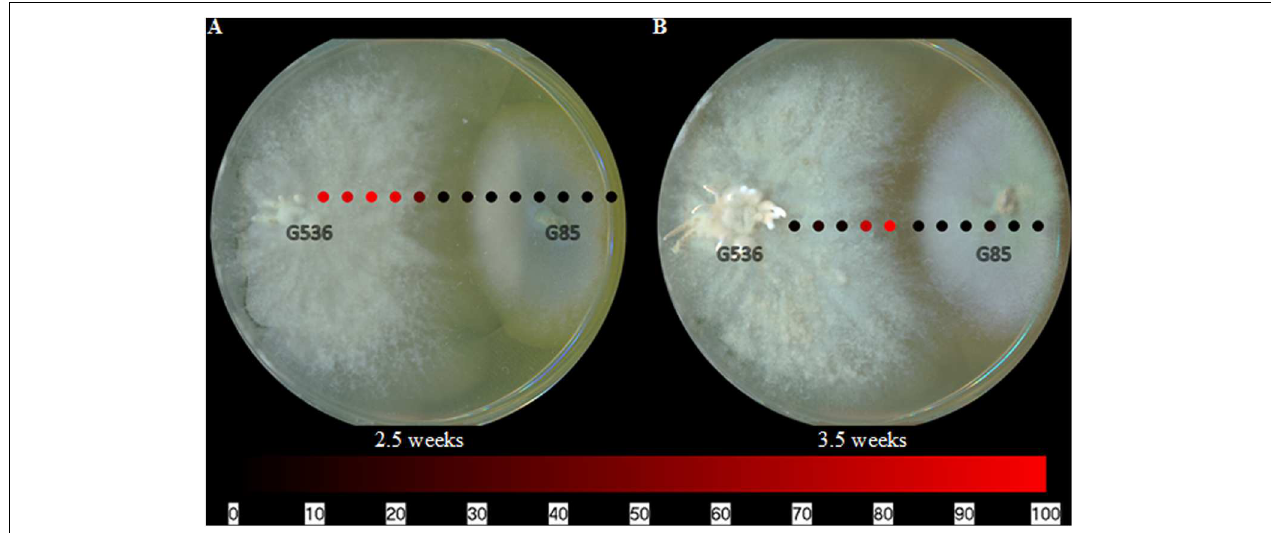
FIGURE 5 | The spatial distribution of griseofulvin from X. cubensis (G536) while grown in co-culture with P. restrictum (G85) at (A) 2.5 weeks and (B) 3.5 weeks. Each circle represents a sampled location. Griseofulvin was most intense where the circles are bright red. The bottom bar indicates the relative amount of signal as measured via mass